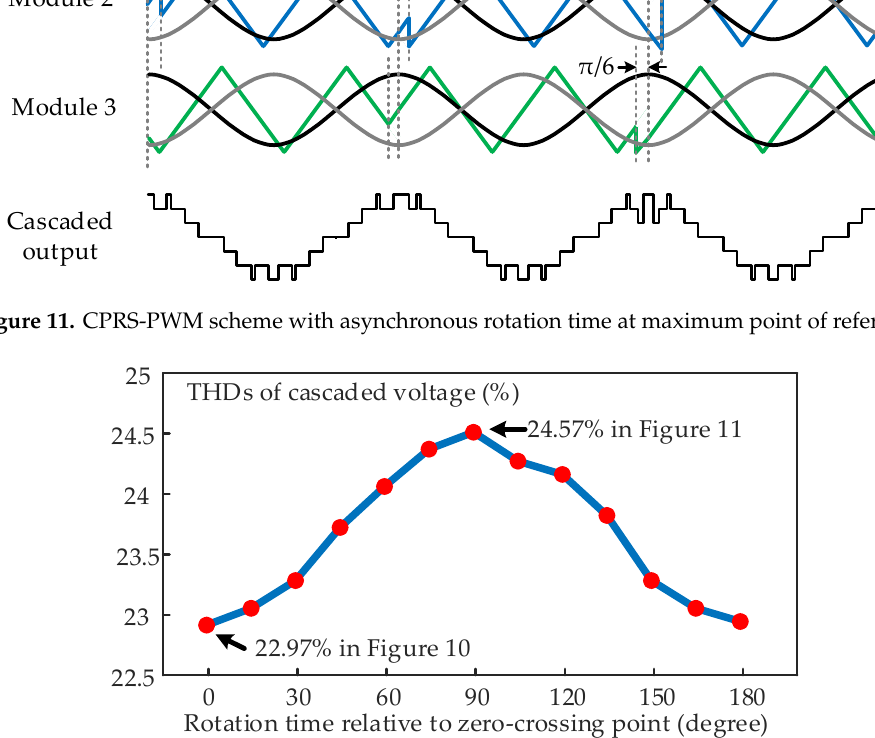
Figure 11. CPRS ‐ PWM scheme with asynchronous rotation time at maximum point of reference. Table 1. Total harmonics distortion (THD) analysis of the cascaded output voltages, shown in Figures 10 and 11.